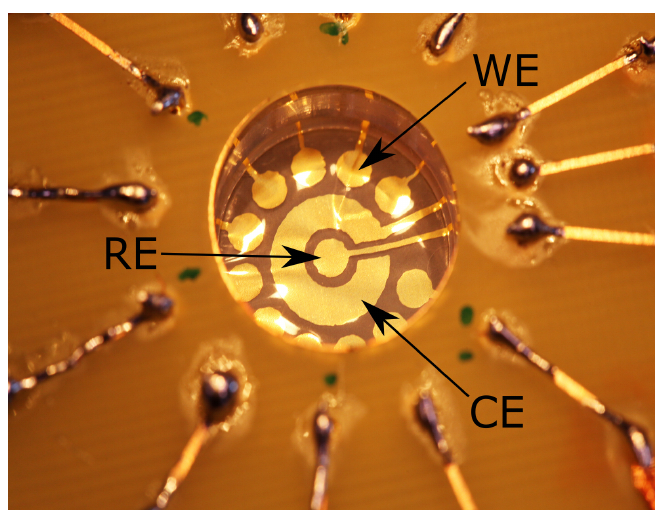
Figure 1. Final design of membrane electrodes enclosed in measurement holder. A central circular electrode serves as a pseudo-reference (RE), around it a large ring electrode is a counter electrode (CE). The RE and CE are surrounded by 11 working electrodes (WE) at the edge of the